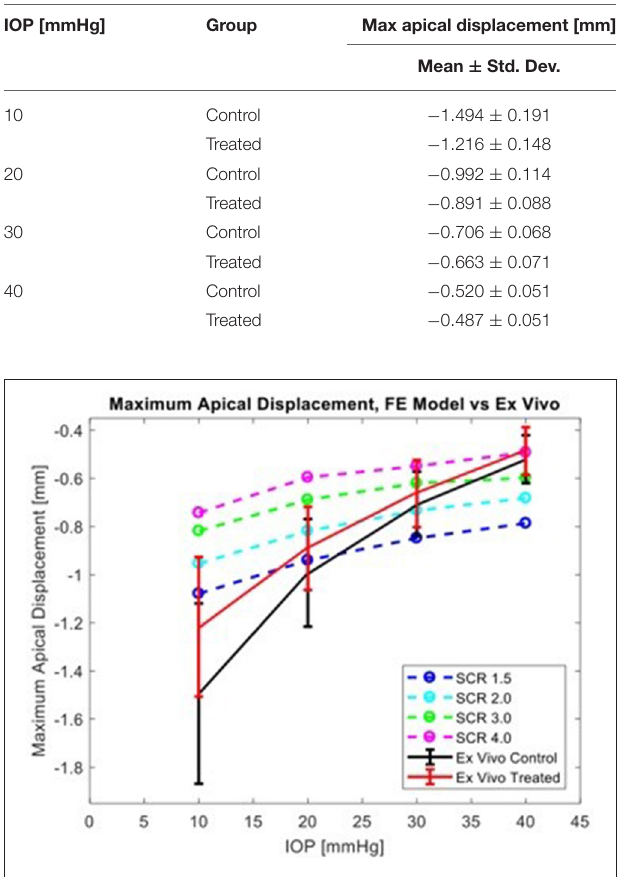
FIGURE 8 | Comparison of simulation results from FE model for several levels of scleral-to-corneal ratio of Youngs’ Modulus (SCRs) against ex vivo data. Error bars represent 95% confidence